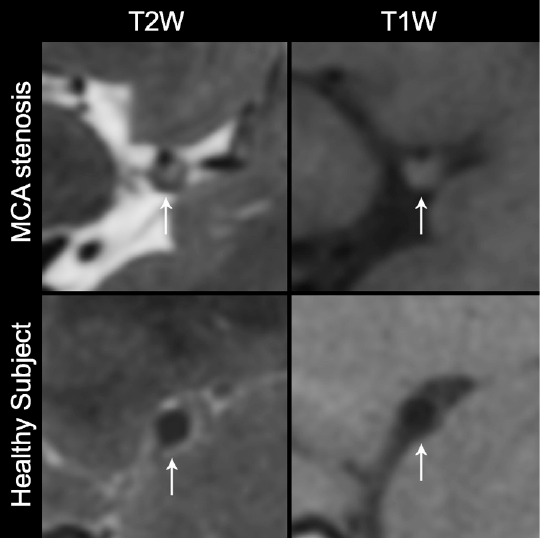
Figure 2. Cross-sectional non-contrast T1 and T2 high-resolution MRI of a subject with middle cerebral artery (MCA) stenosis and a healthy subject. The white arrows indicate the stenotic MCA and a thick plaque of the subject with MCA stenosis (top row) and the thin and smooth vessel wall of